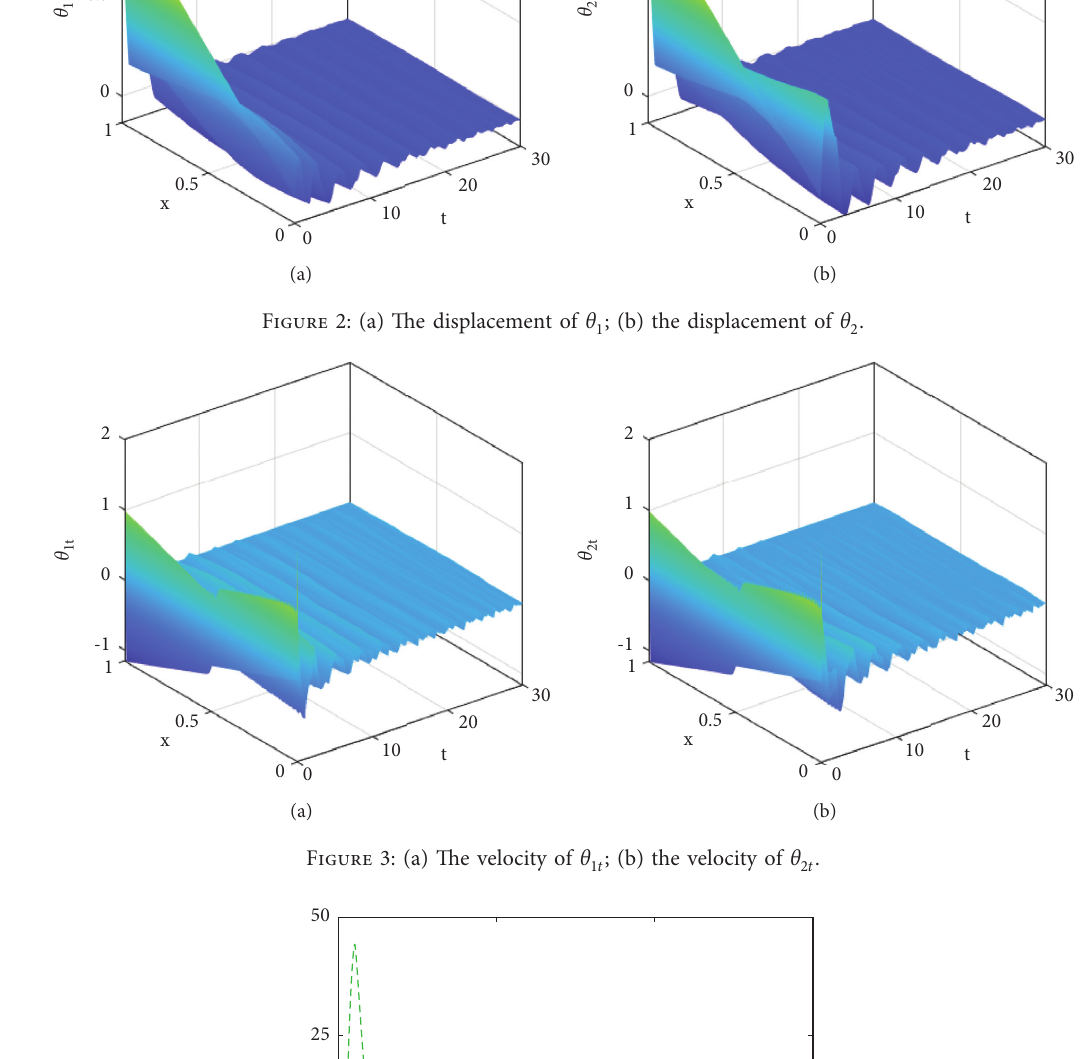
; (b) the velocity of θ 1 t